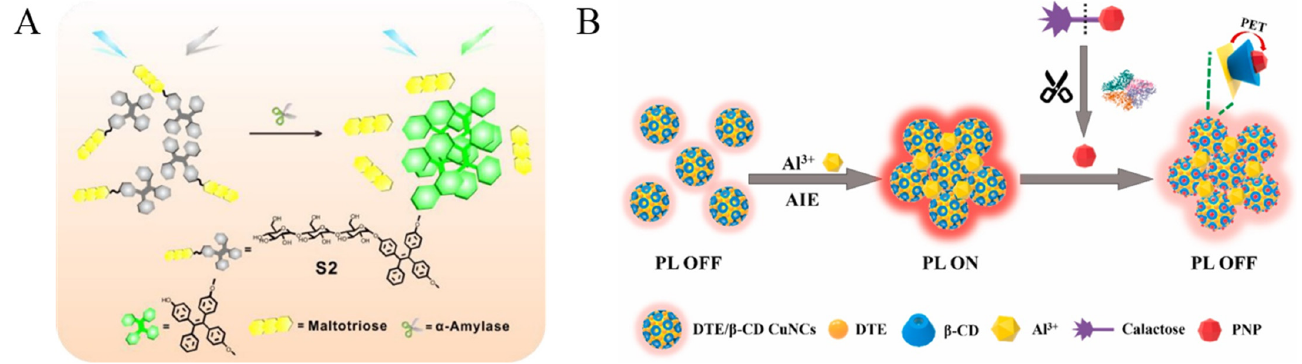
Figure 9. ( A ) Schematic illustration of the sensing mechanisms of the probe S2 in α -amylase activity sensing. Reprinted with permission from ref. [84]. Copyright 2018, American Chemical Society. ( B ) Schematic representation of the strategy for the determination of β -Gal. Reprinted with permission from ref. [87]. Copyright 2020, American Chemical Society. Table 3. Analytical performances of AIE-based methods for the detection of